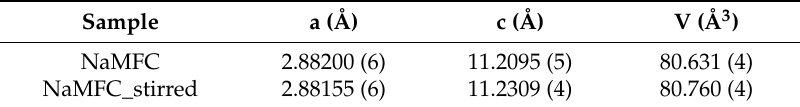
Table 3. Cell parameters of the P2 phase (P6 3 / mmc ) NaMFC and NaMFC_stirred refined following the Lebail method using the neutron diffraction